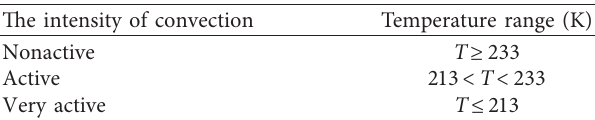
Table 4: The cloud top temperature scale used for the classification of the convection intensity (adapted from